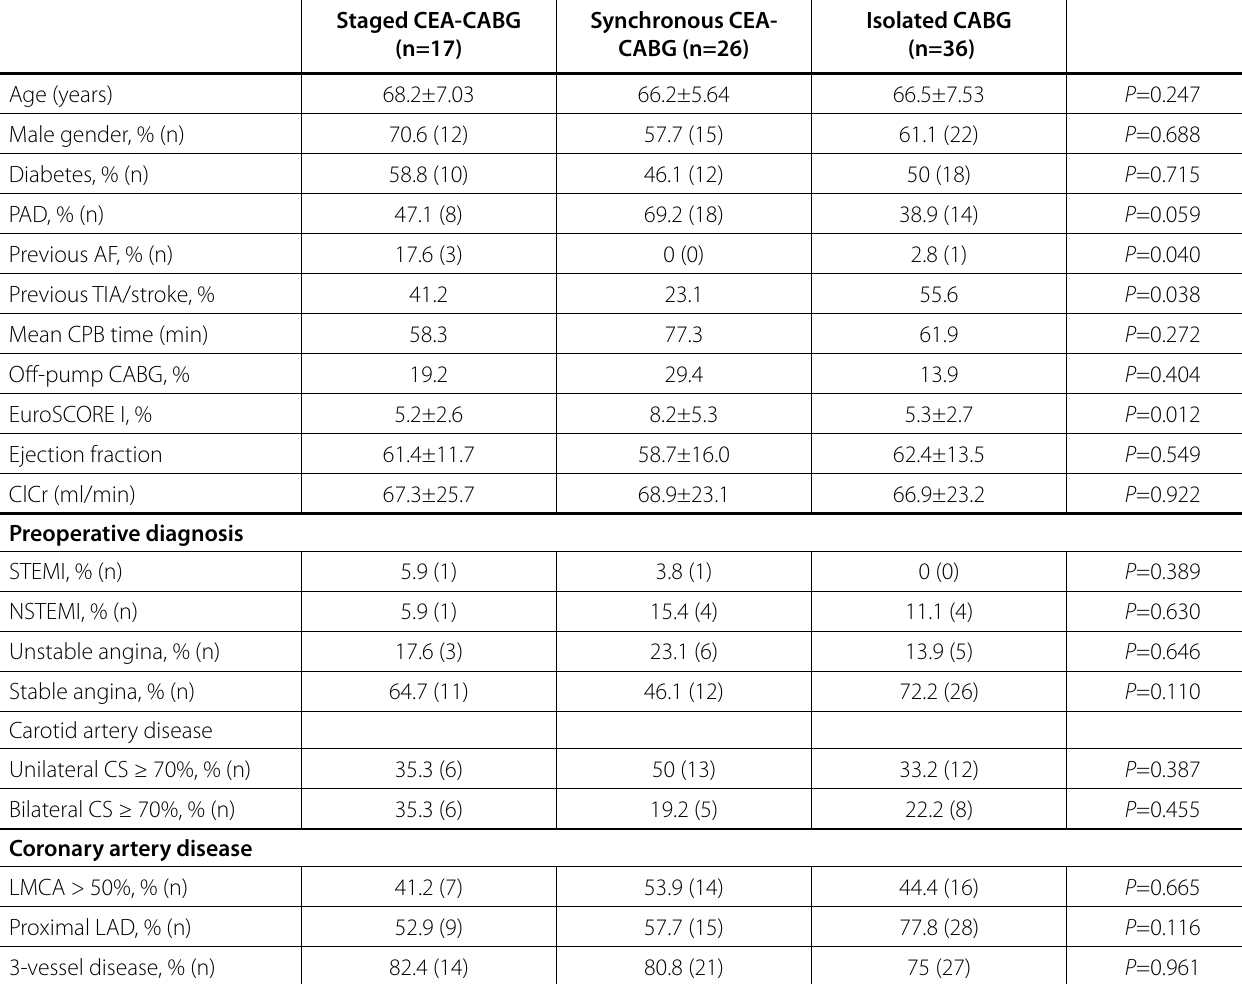
Table 1. Patients’ demographic and baseline characteristics. Staged